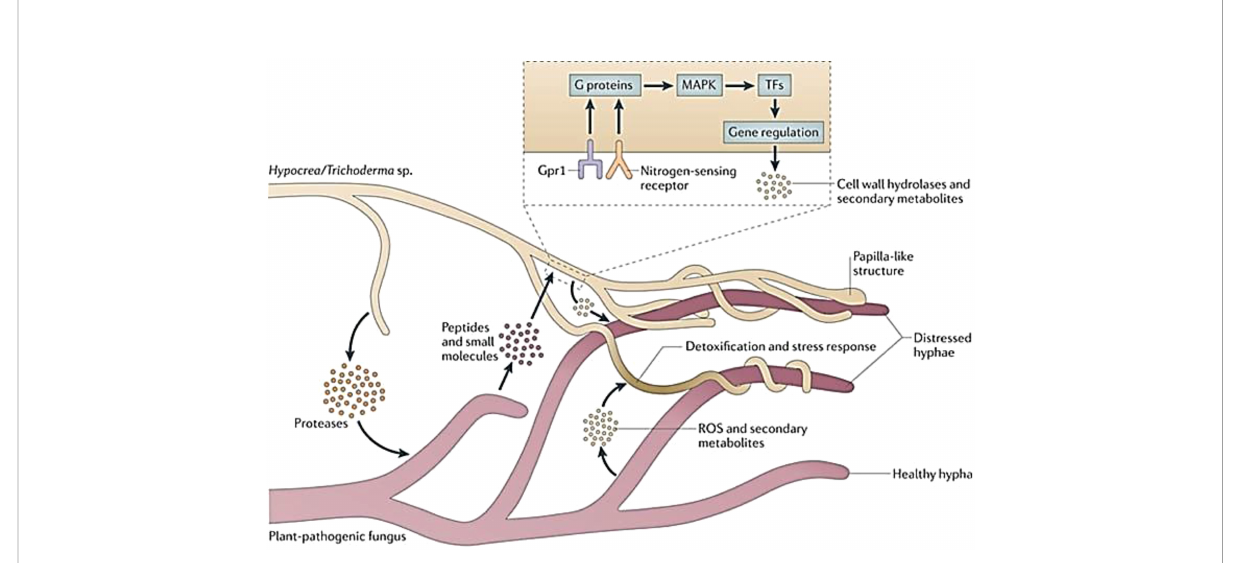
FIGURE 2 Mycoparasitism of Trichoderma spp. within the soil community (adopted from Druzhinina et al.,